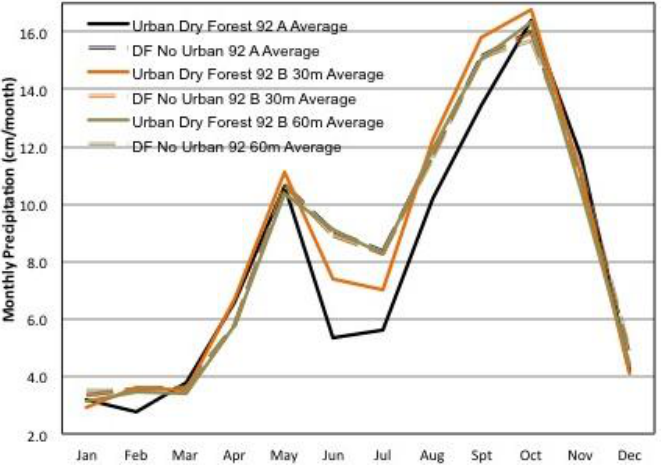
Figure 10. Average monthly precipitation for the dry forest urban 1992 A and non-urban.